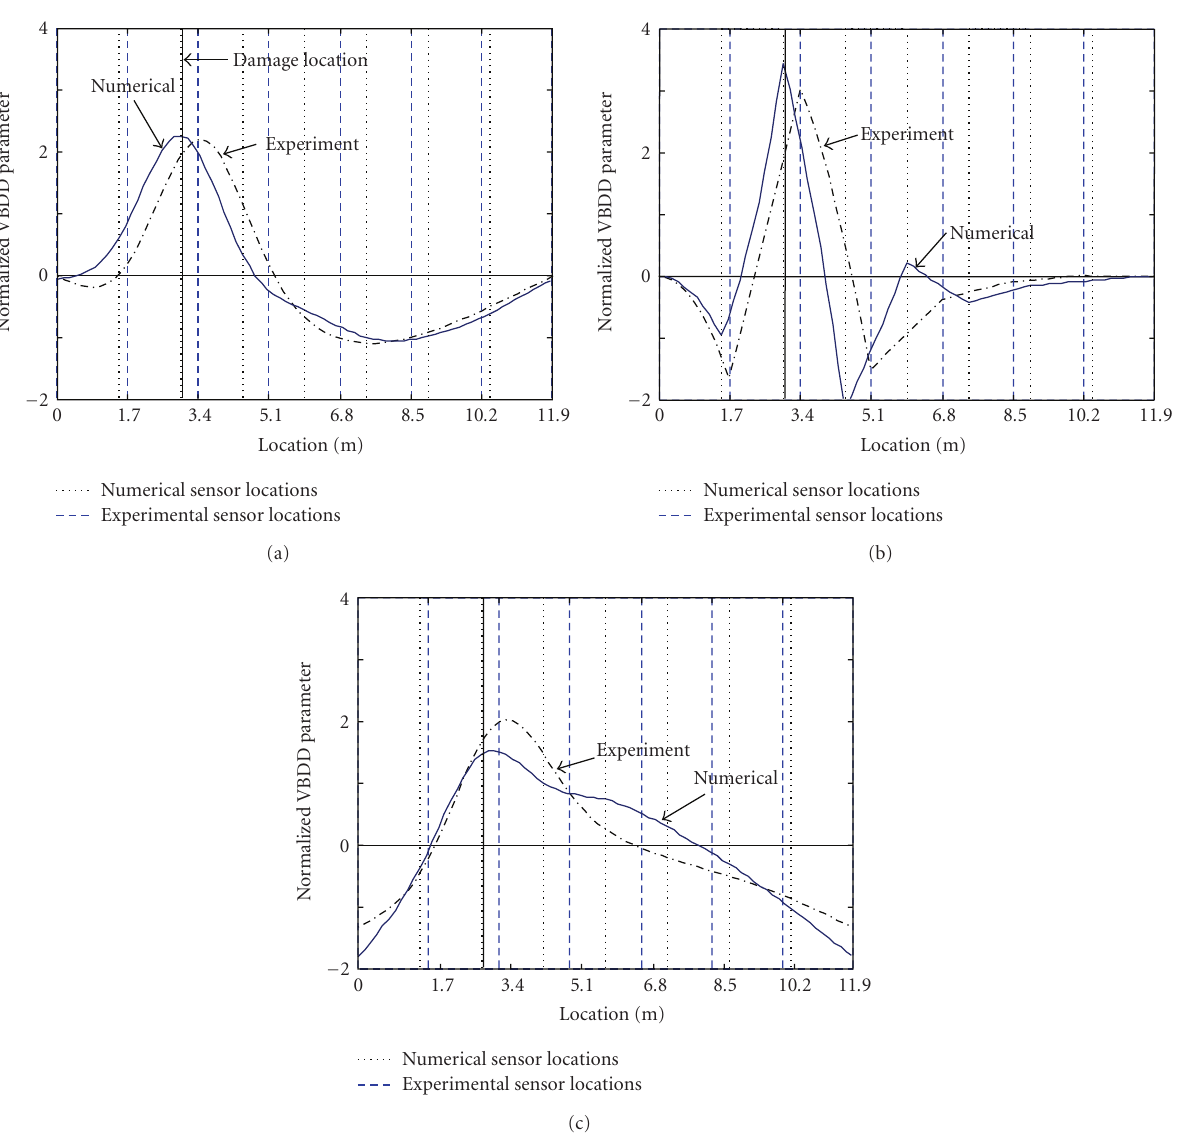
Figure 16: Comparison of VBDD parameter distributions produced for experimental damage case 6 (3.0m from support, 6 measurement points) and numerical damage case 21 (3.05m from support, 7 simulated measurement points) by (a) CMS, (b) DI, and (d) MCF methods.